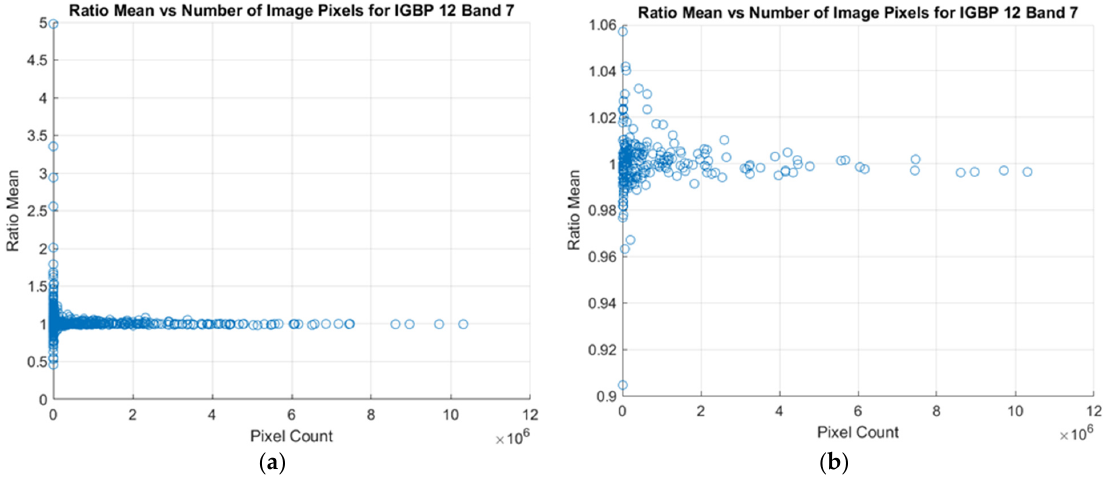
Figure 11. ( a ) Unfiltered ratio mean vs. number of pixels. ( b ) Filtered ratio mean vs. number of pixels.